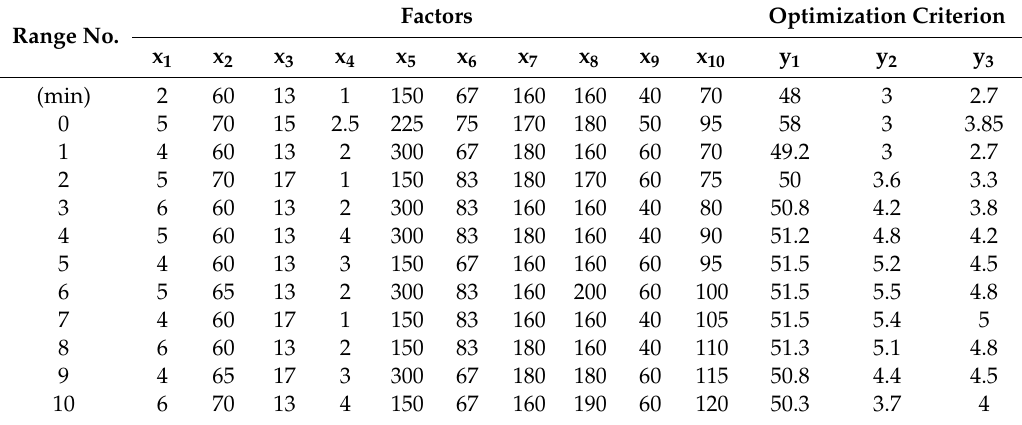
Table 2. Matrix of Plasma Spraying Experiments